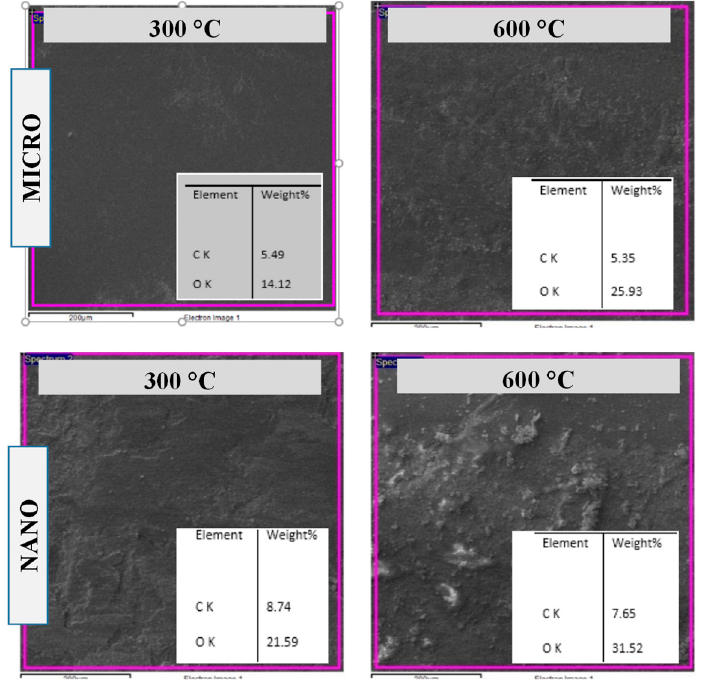
Figure 6. EDS analysis conducted on the wear tracks of the micron-and nano-sized WC samples after the wear test conducted at a load of 30 N, a speed of 0.1 m/s and at temperatures of 300 °C and 600 °C.